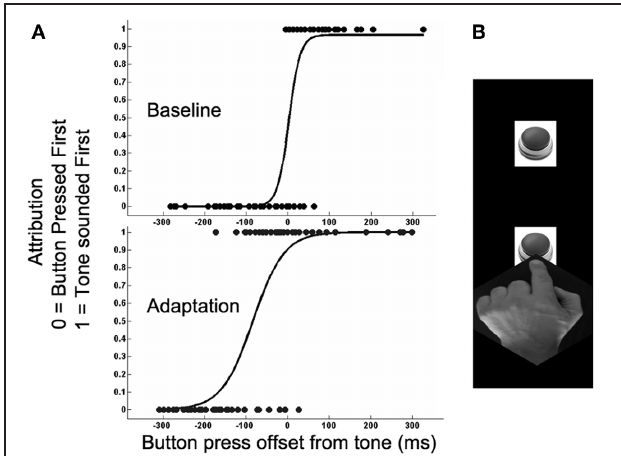
FIGURE 1 | (A) Plots depicting when a participant felt they had pressed a button before they had heard a tone on the final sequence of a trial, expressed as a function of the physical timing differences between these events. Tones were presented at 0ms. Negative values signify that the further button was pressed before the tone, whereas positive values signify that the further button was pressed after the tone. Data is depicted for a representative participant from baseline (above) and adaptation (below) runs of trials in Experiment 1a. (B) Depiction of experimental paradigm. This involved participants resting their finger on the nearer of two buttons and then, when they chose, reaching out as fast as possible to press the far button. During a trial this sequence was repeated up to 8 times. On all but the final sequence pressing the far button triggered a tone. On the final sequence the tone was not triggered by the participant pressing the far button but, after a delay, by the participant lifting their finger from the nearer button. This allowed us to sample tone presentation times that both preceded and lagged the final press of the further button. See Methods for further